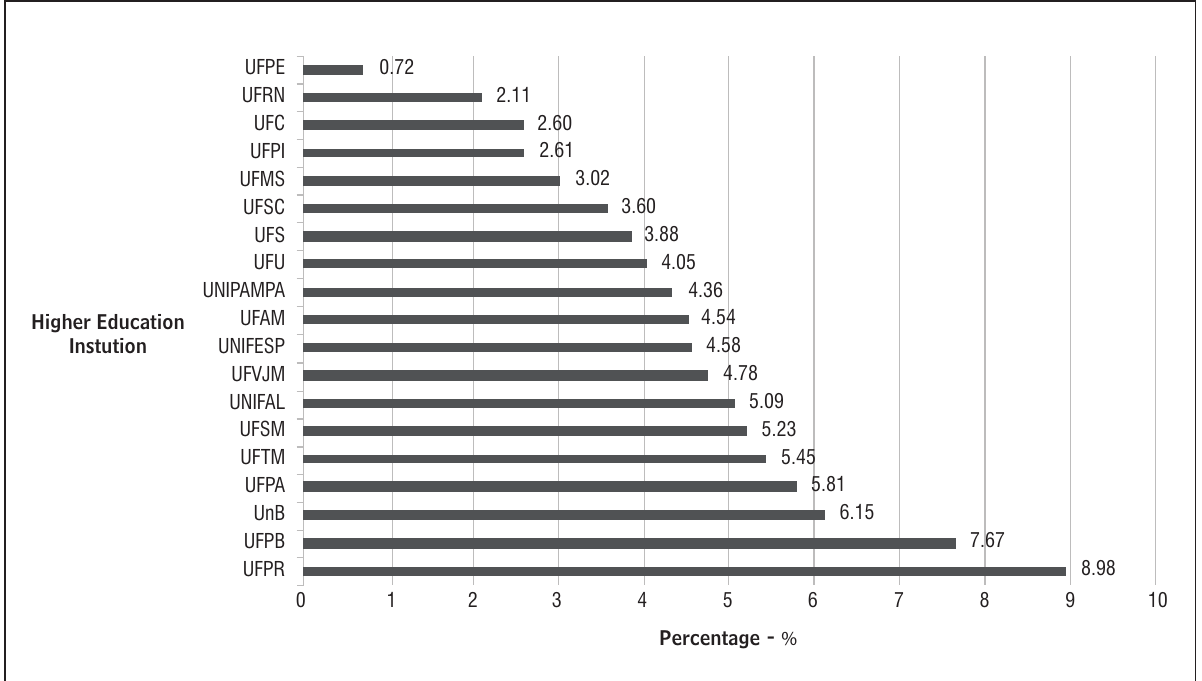
Figure 1 - Percentage distribution of recommended complementary activities in hours compared to the total course load in hours, including university extension activities, by institution Note: Not included in Figure 1: UFSCar (no documentation was found on required academic activities); UFCSPA and UFRGS (the number of hours granted varied according to each